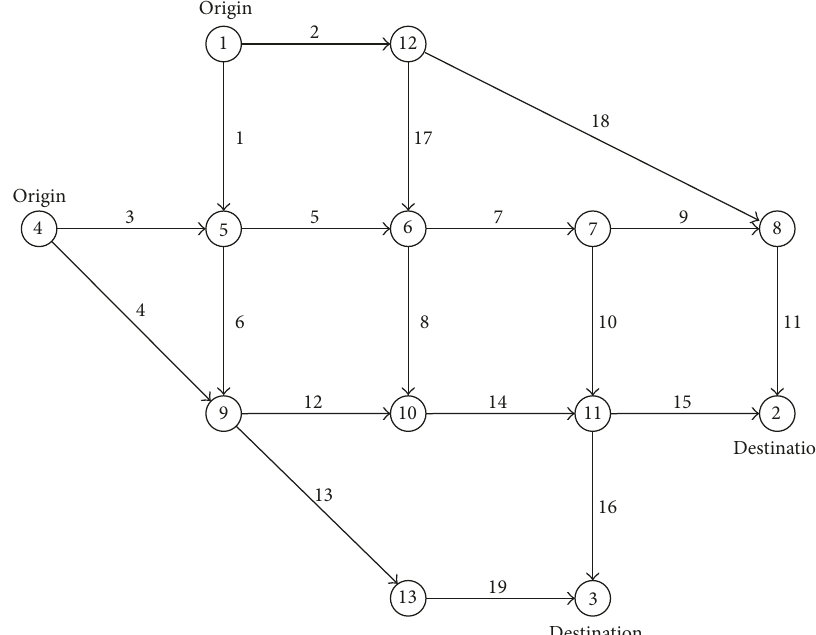
Figure 3: The Nguyen and Dupuis network.